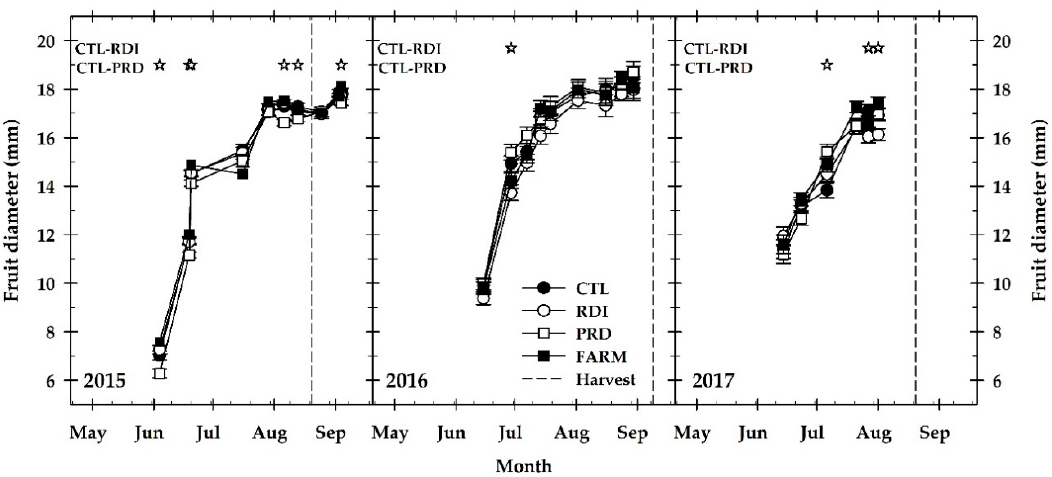
Figure 4. Evolution of the fruit equatorial diameter for all irrigation treatments: CTL (black circles), RDI (white circles), PRD (white squares) and FARM (black squares) during the three years assayed (2015–2017). Each point is the mean ± SE of n = 60 fruit. Vertical dashed lines indicate veraison for every season. Stars indicate statistically significant differences between treatments according to Duncan’s multiple range test ( p < 0.05).